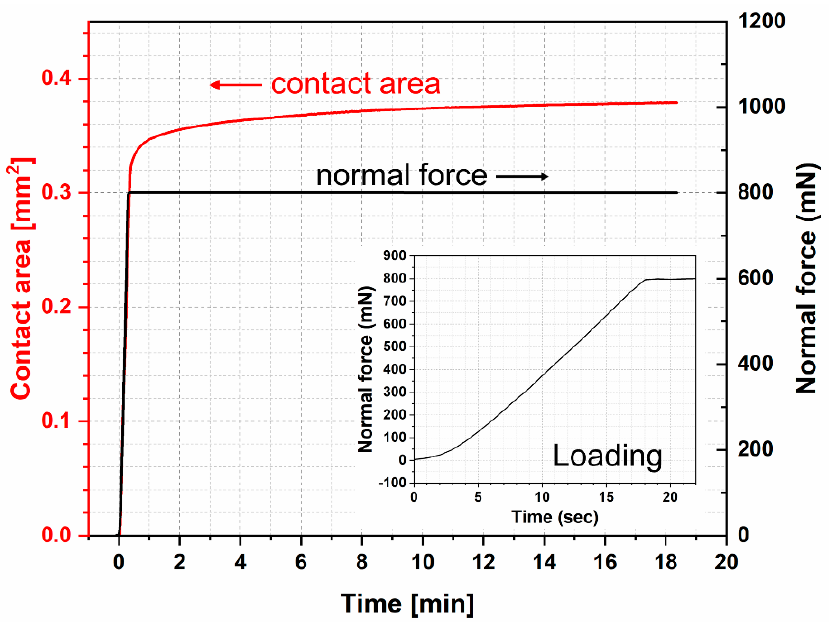
Figure 3. Force-controlled creep test of FKM fluoroelastomer.